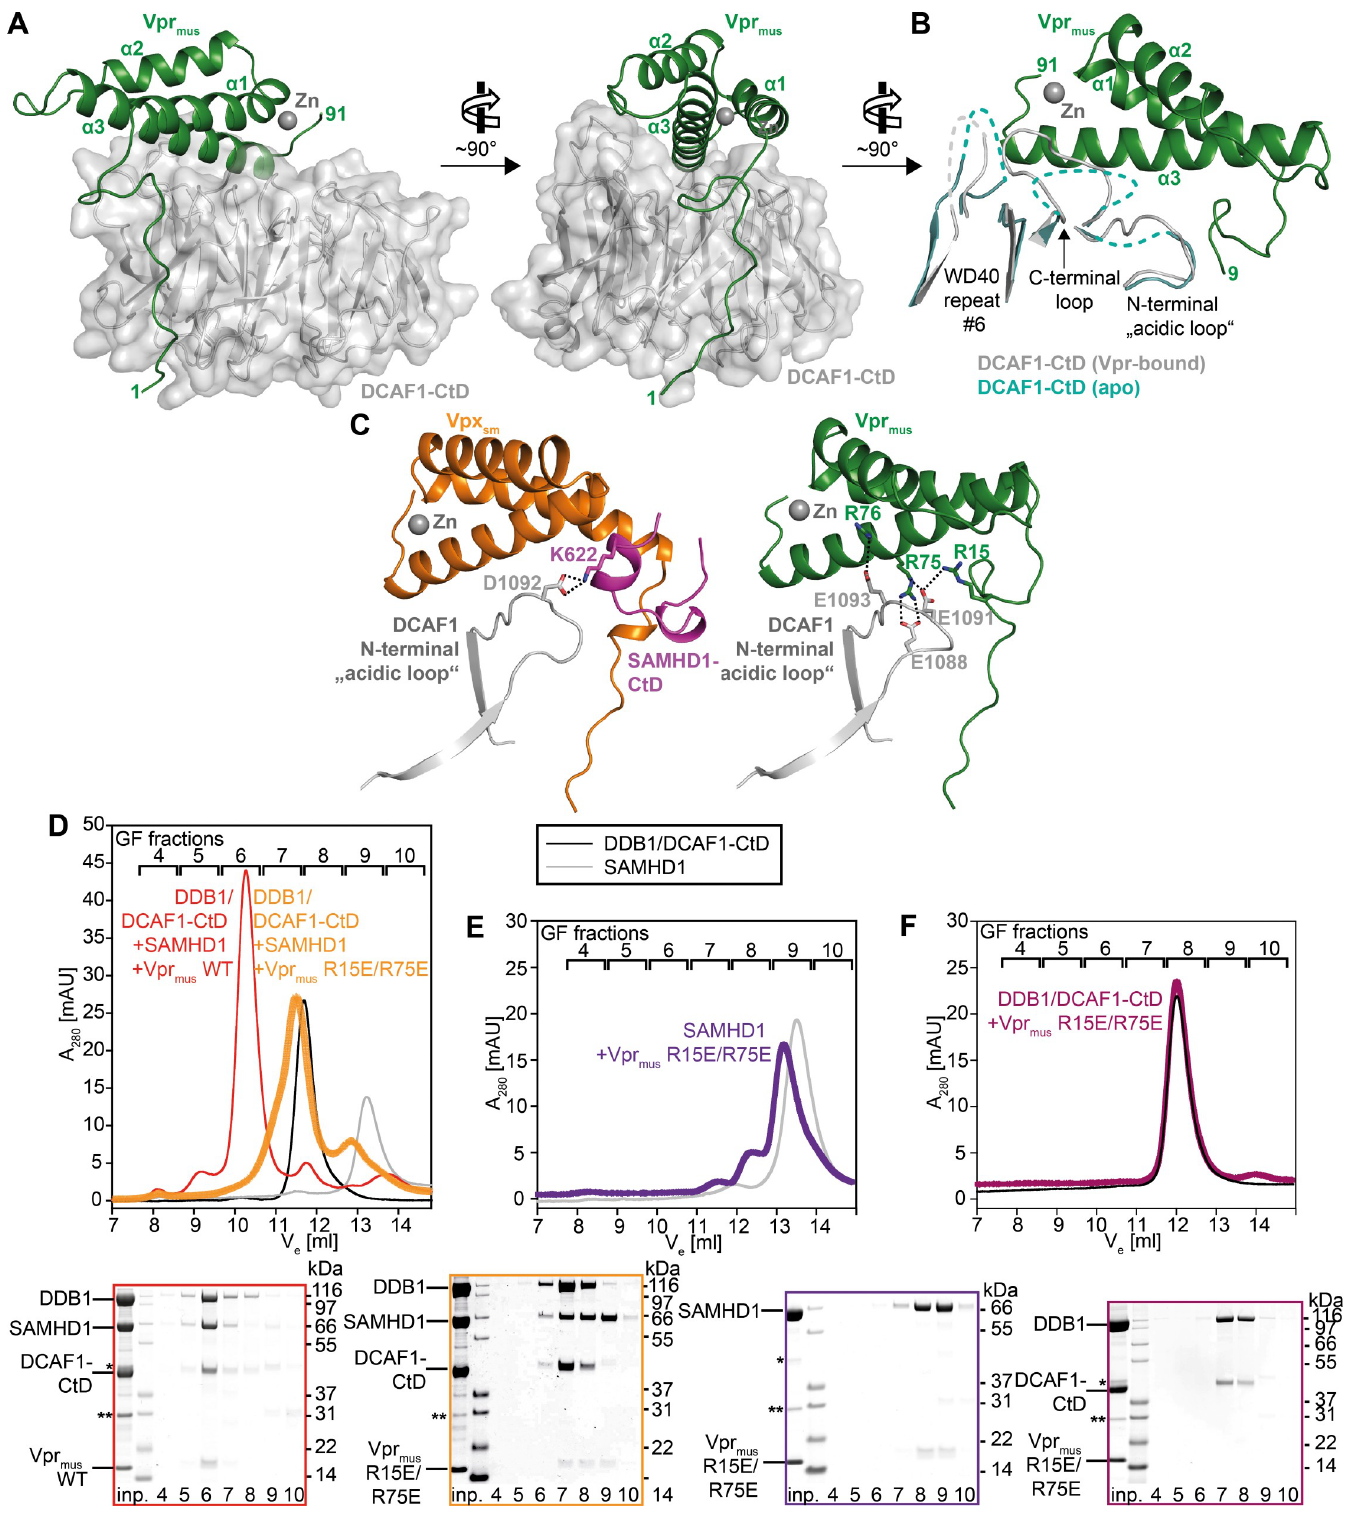
Fig 2. Crystal structure of the DDB1/DCAF1-CtD/Vpr mus complex. ( A ) Overall structure of the DDB1/DCAF1-CtD/Vpr mus complex in two views. DCAF1-CtD is shown as grey cartoon and semi-transparent surface. Vpr mus is shown as a dark green cartoon with the co-ordinated zinc ion shown as grey sphere. T4L and DDB1 have been omitted for clarity. ( B ) Superposition of apo-DCAF1-CtD (light blue cartoon) with Vpr mus -bound DCAF1-CtD (grey/green cartoon). Only DCAF1-CtD regions